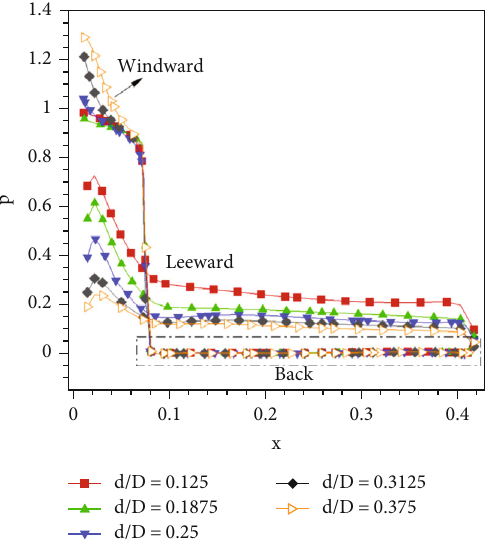
Figure 16: Wall pressure distribution of a blunt body at a pitch angle of 20 °